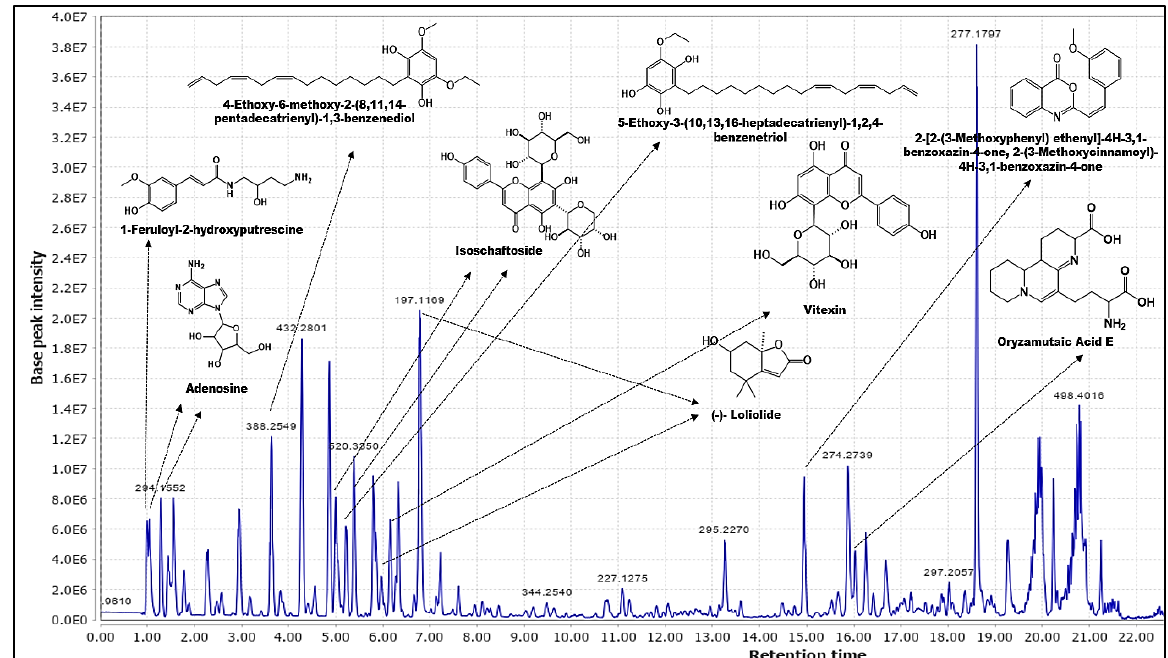
Figure 2. Identified phytochemicals from MZmine 2.53 based on TIC.